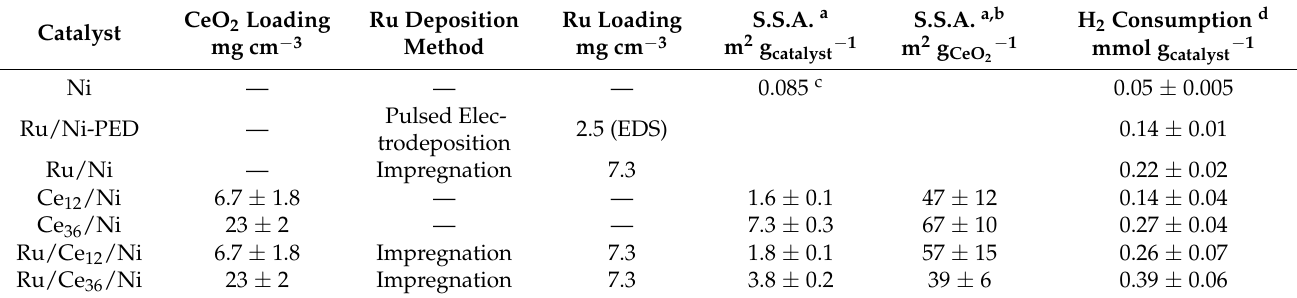
Table 1. Composition, specific surface area (S.S.A.), and H 2 consumption during temperature programmed reduction (TPR) experiments of the investigated foam